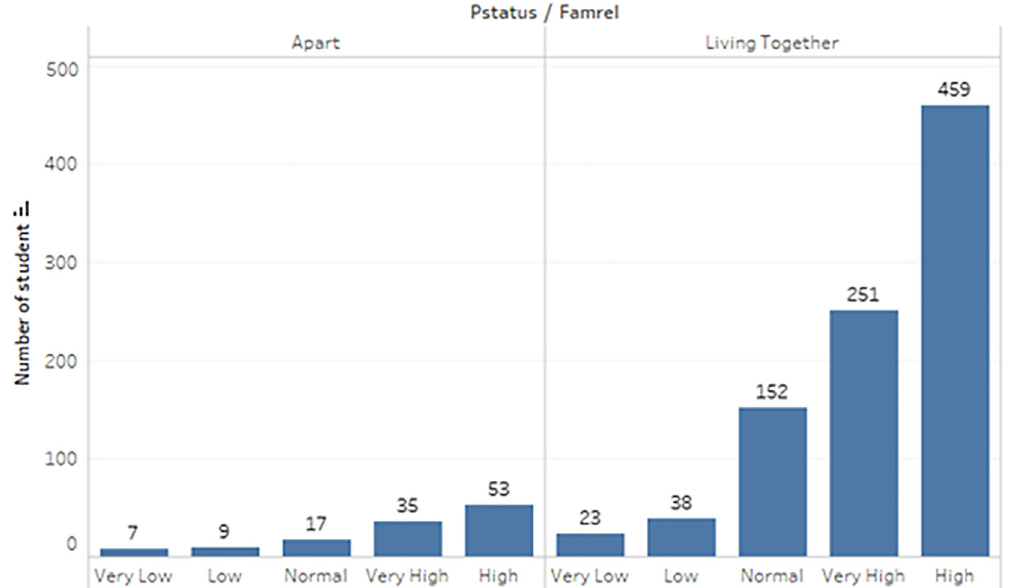
Figure 6. Distribution of relationship with parents.